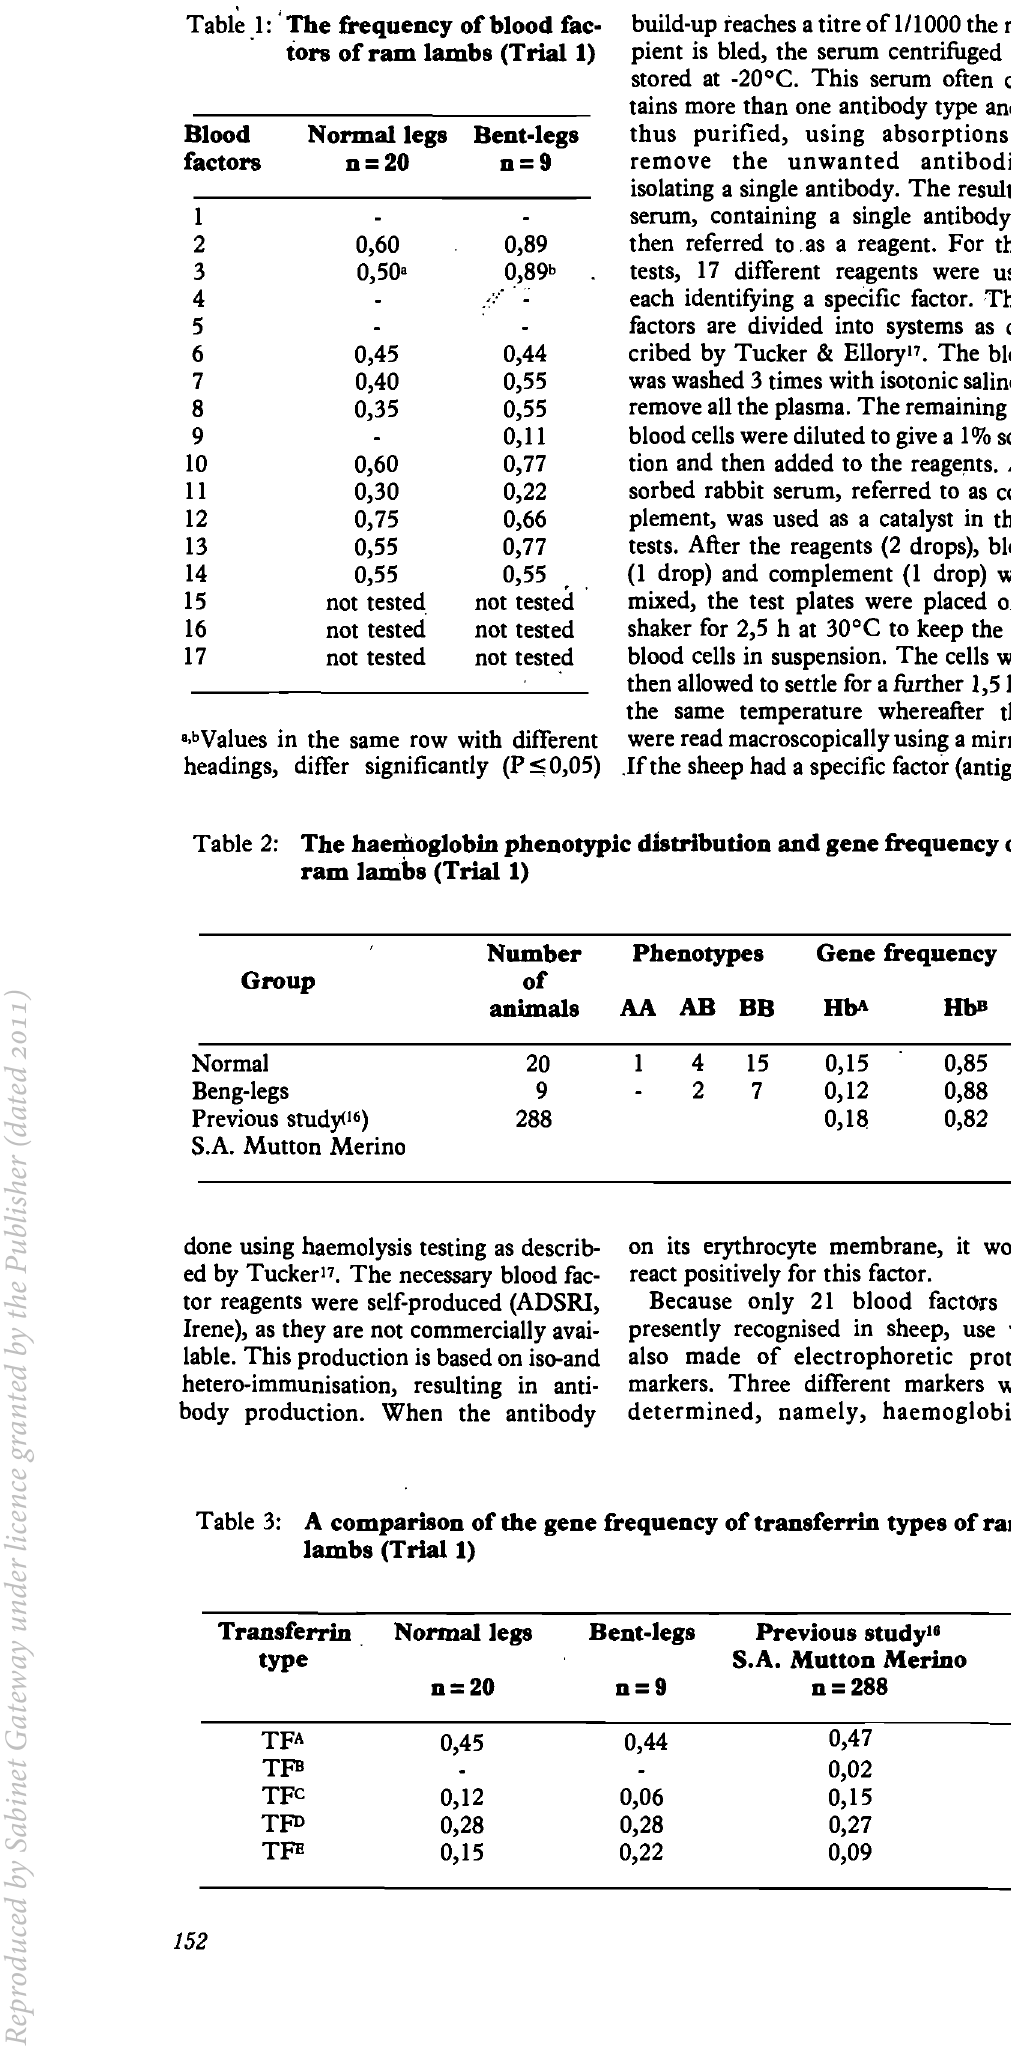
Table 3: A comparison of the gene frequency of transferrin types of